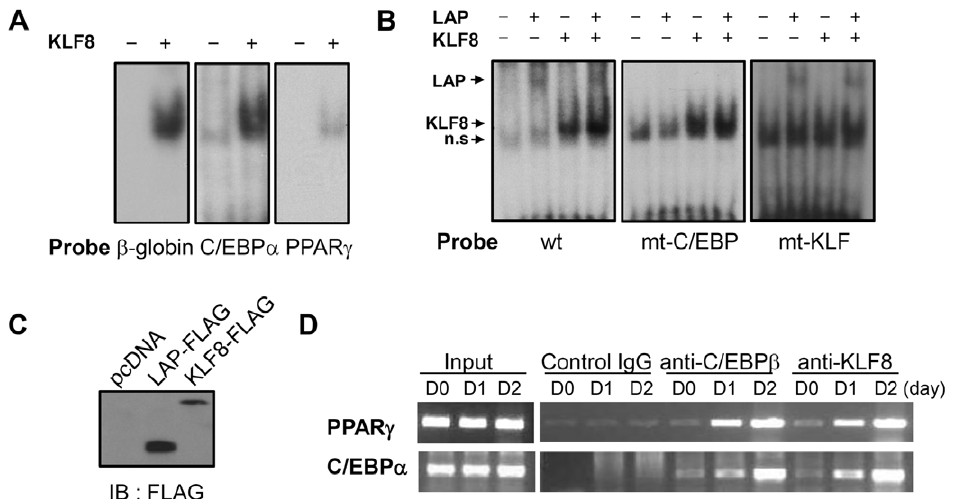
Figure 5. KLF8 directly binds to C/EBP a and PPAR c 2 promoter. (A) EMSA experiment using KLF binding sites of b -globin (positive control), C/ EBP a , or PPAR c 2 promoter as probes. A FLAG-tagged KLF8 protein was in vitro translated using TNT T7 quick master mix. (B) EMSA experiment using wild type or mutated probe of the C/EBP a promoter. FLAG-tagged C/EBP b -LAP or KLF8 protein was in vitro translated using TNT T7 quick master mix. (C) Western blot analysis of the in vitro translated proteins. n.s, non-specific. (D) ChIP was performed on 3T3-L1 cell chromatin at the indicated time points after induction of differentiation, using control IgG, anti-C/EBP b , or anti-KLF8 antibody. The immunoprecipitated DNA was used as a PCR template to detect the PPAR c or C/EBP a promoter